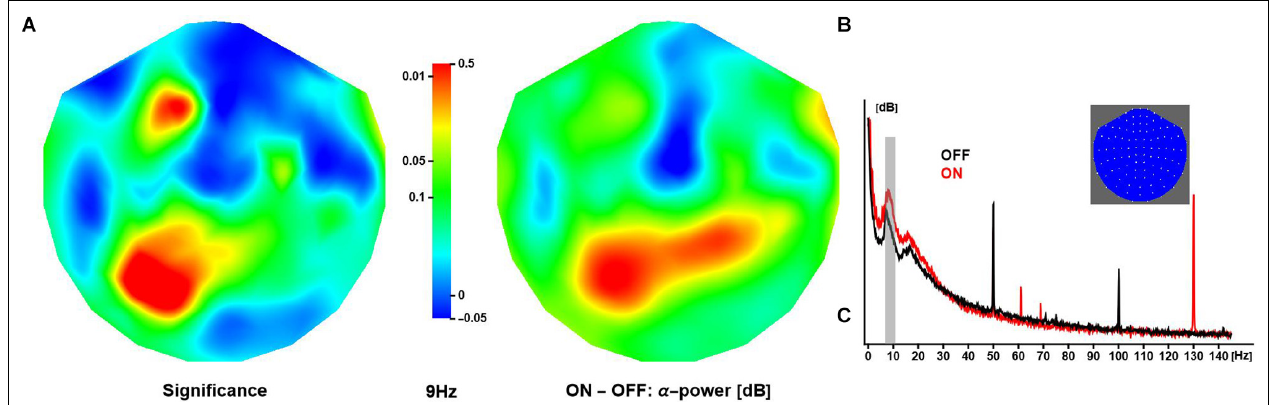
FIGURE 2 | Effect of deep brain stimulation on resting α -activity. (A) The panel shows the spatial distribution of significance of the difference in (grand-mean) α -power (at 9 Hz) between conditions, where activity is larger in ON compared to OFF sessions (middle panel). The relative increase in activity over anterior and posterior regions is about 0.3 dB and 0.5 dB, respectively. (B) The panel shows OFF and ON spectra obtained in one patient. Note these are raw spectra in which line noise has not been attenuated. The inset shows a 2D projection of the MEG channels (right ear on right, front at